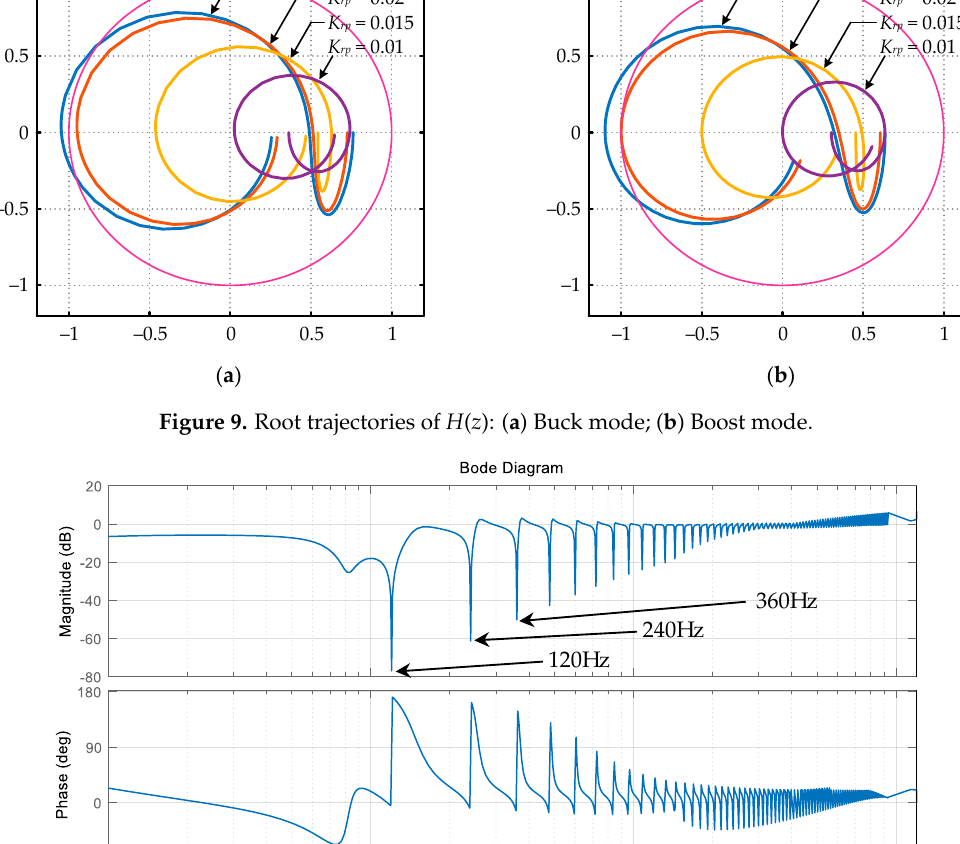
( a ) ( b ) Figure 11. Simulation results applying repetitive controller at 0.2 s in buck mode: ( a ) Input current and current error at load = 800 W; ( b ) Input current and current error at load = 100 W.